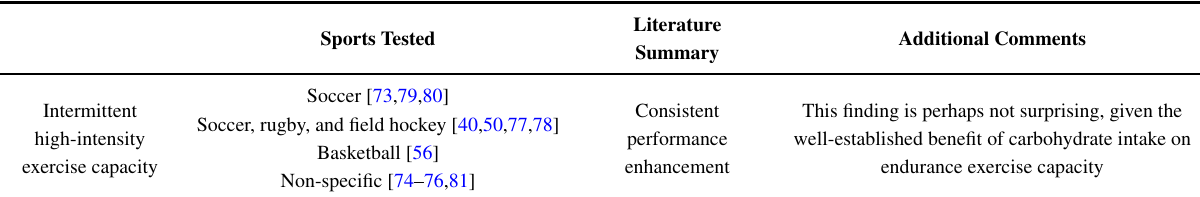
Table 2. Literature summary: Effect of carbohydrate intake during exercise on intermittent sports